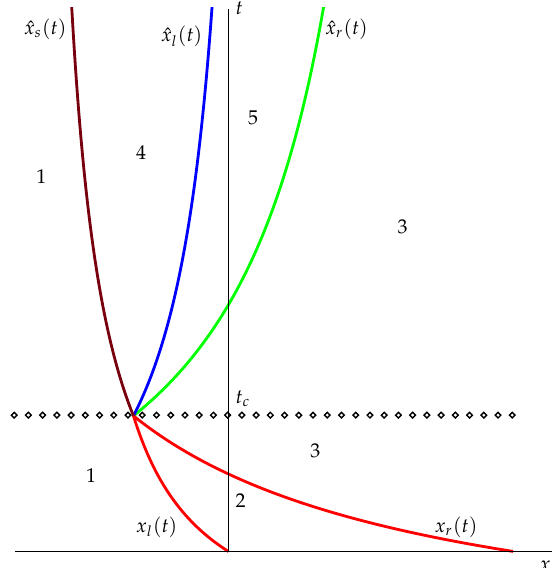
Figure 3. Behaviour in the ( x , t ) plane of the solution of (62), (64). In red, the characteristics x l ( t ) and x r ( t ) given in (67) and (70), respectively. In black, the shock line ˆ x s ( t ) characterised in (81). In blue, the characteristic ˆ x l ( t ) , and in green, the characteristic ˆ x r ( t ) determined in (84). In regions 1 and 3, the solution is given, respectively, by (67) and (70), while in region 2 it is given by (68). In region 4, the solution is determined by (80), while in the region 5, we find the generalised rarefaction wave characterised in (82),